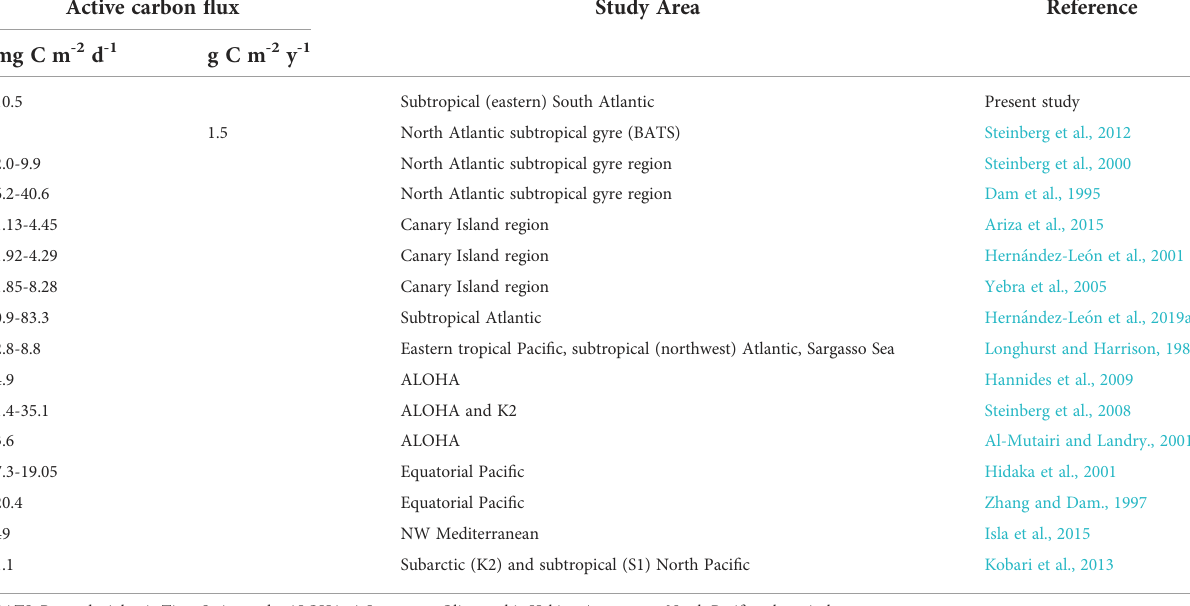
TABLE 3 Literature data of active carbon fl uxes (respiratory carbon) from epi- to mesopelagic depths mediated by mesozooplankton in different areas/regions of the world ocean in comparison with our study. Active carbon fl